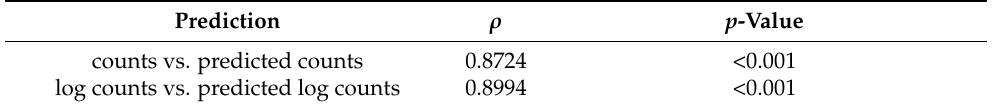
Table 1. Pearson correlation coefficients between the count and log predictions of the SIDE model and the actual values for the first 40 weeks of